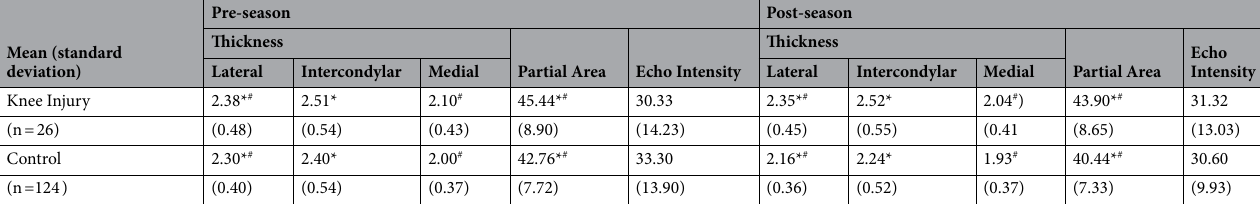
Table 2. Femoral cartilage variables at pre-and post-season assessments for the knee injury history and control groups. *Significant main effects for group ( p < 0.05) indicate that the knee injury group had greater lateral and intercondylar thickness as well as partial area than the control group, regardless of pre-and post- season time points. # Significant main effects for time ( p < 0.05) indicate that pre-season femoral cartilage values were greater than post-season values, regardless of